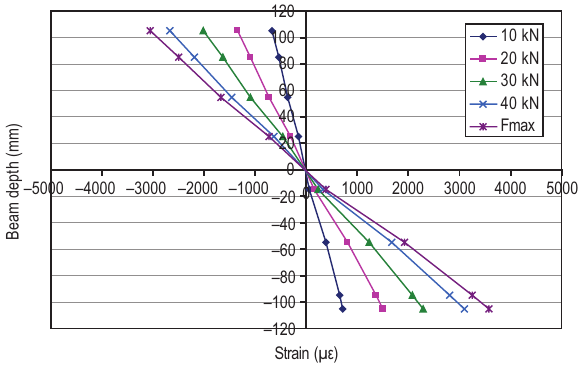
Fig. 8. Strain profile at different load levels for unreinforced beams (Beam A3)